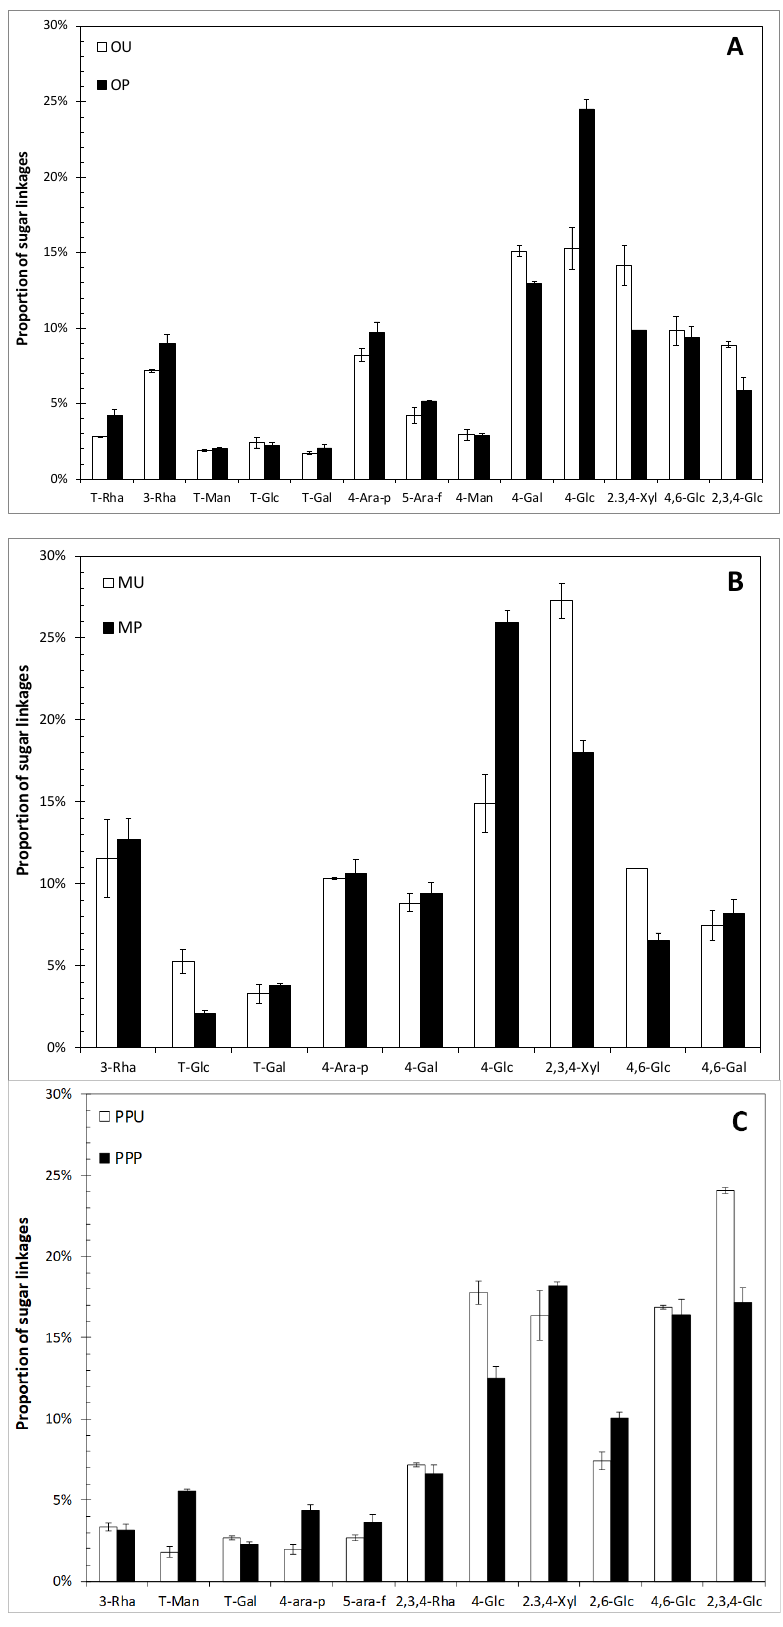
Figure 1. Sugar linkage proportions (%) of untreated and HHP-treated ( A ) orange, ( B ) mango and ( C ) prickly pear peels. Values are the means of triplicates and expressed in dw